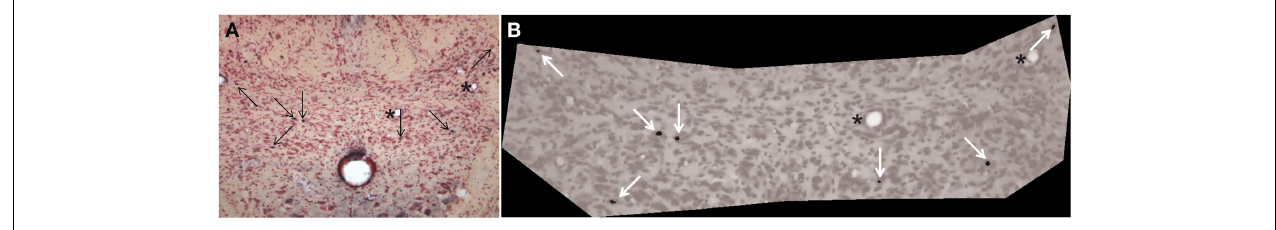
discrimination [ (B) white arrows] in this case, but this did not always happen. Neurons sometimes were excluded if they were too lightly stained or too small ( < 11 pixels). Asterisks show similar blood vessels in either